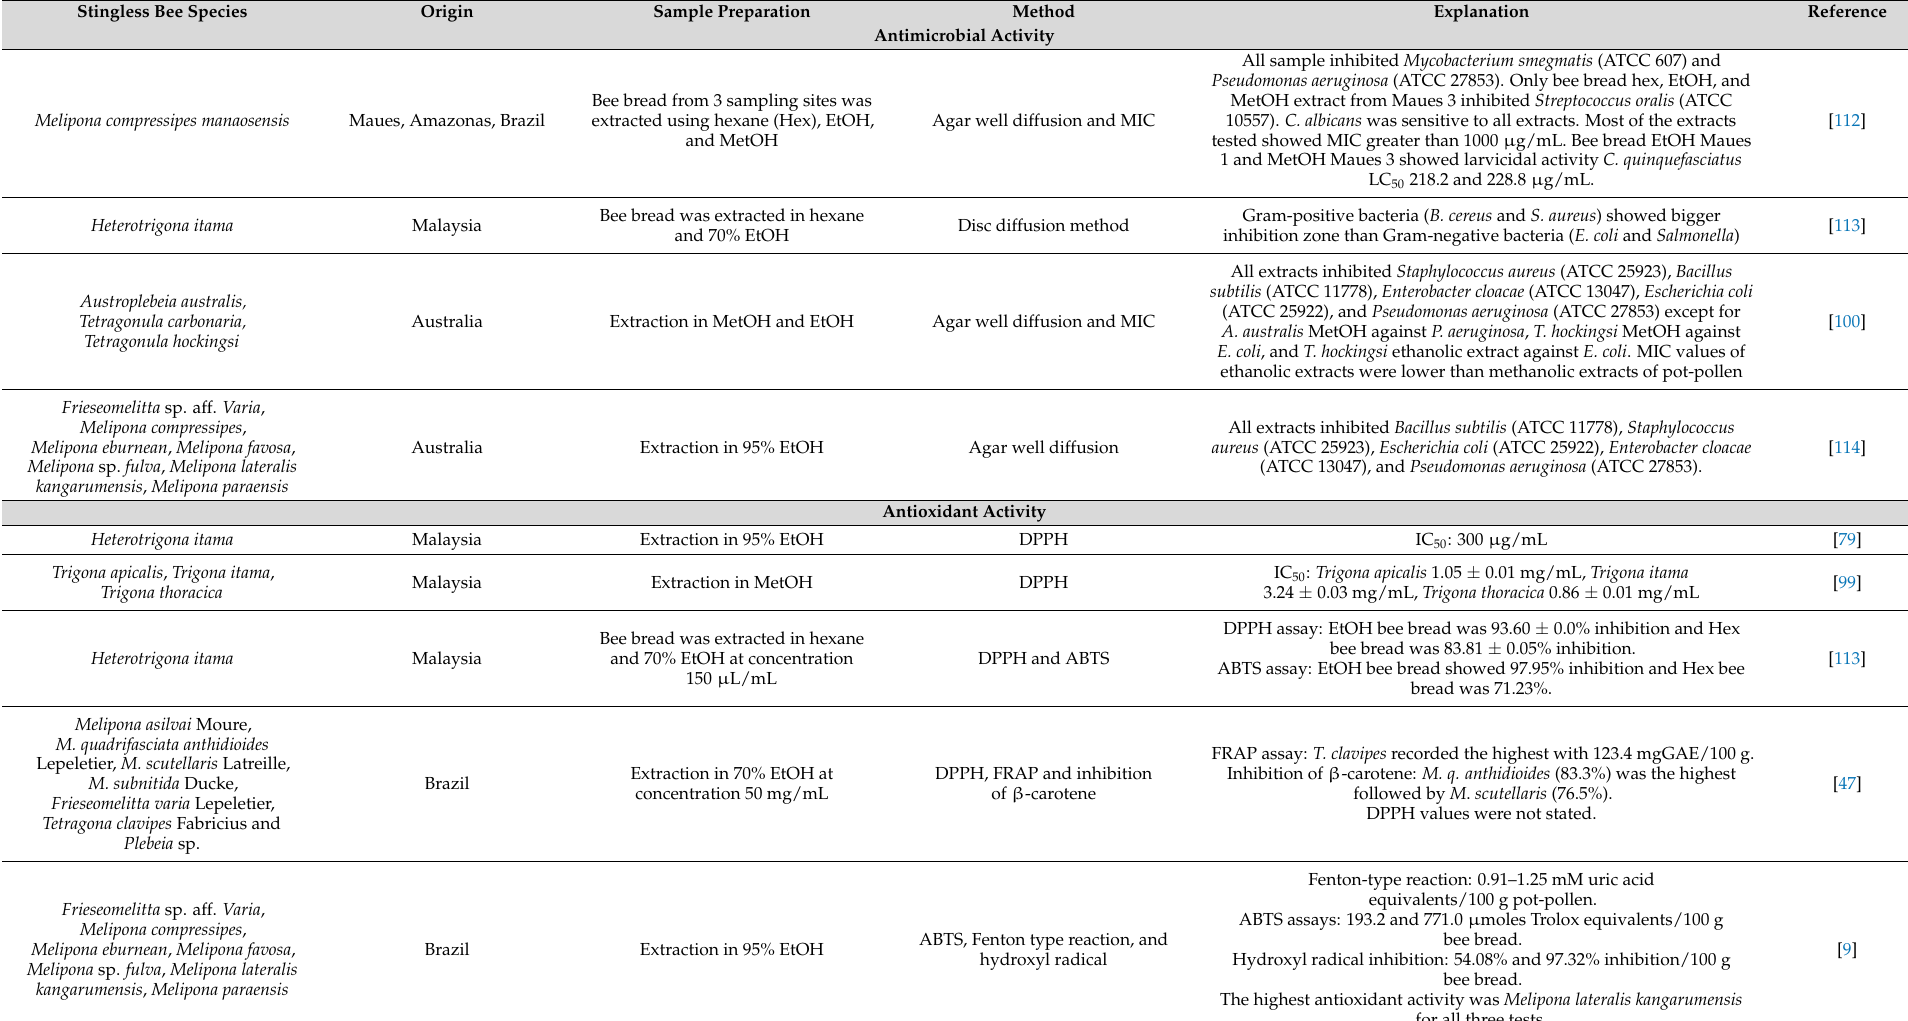
Table 6. Health benefits of stingless bee bee